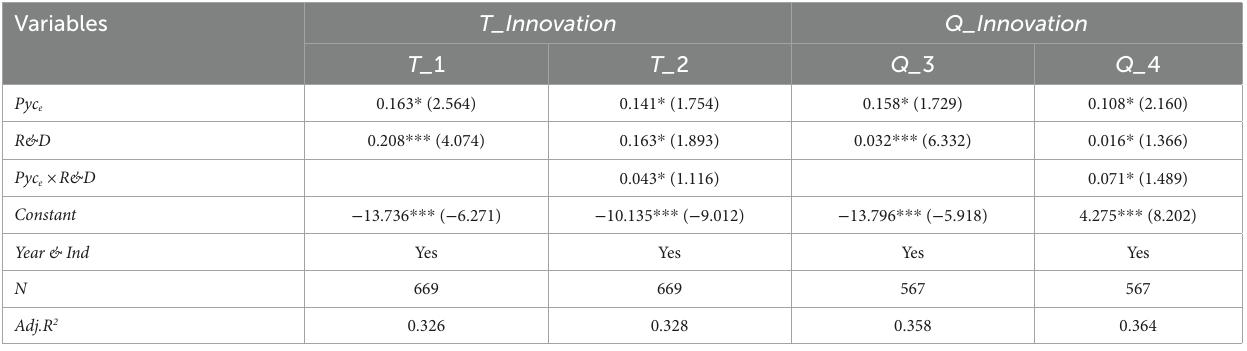
TABLE 10 The moderating effect of R&D investment on executives’ psychological capital and enterprise innovation.